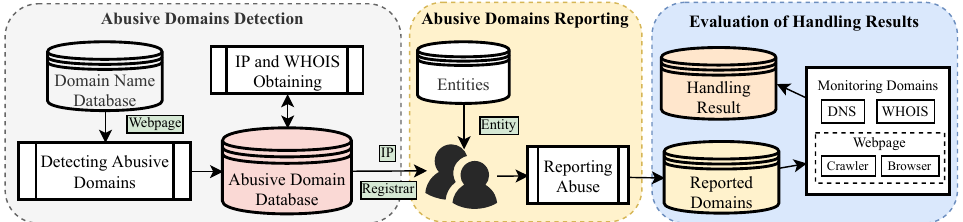
Figure 4. The process of evaluating the effectiveness of Internet entities in dealing with abusive domain